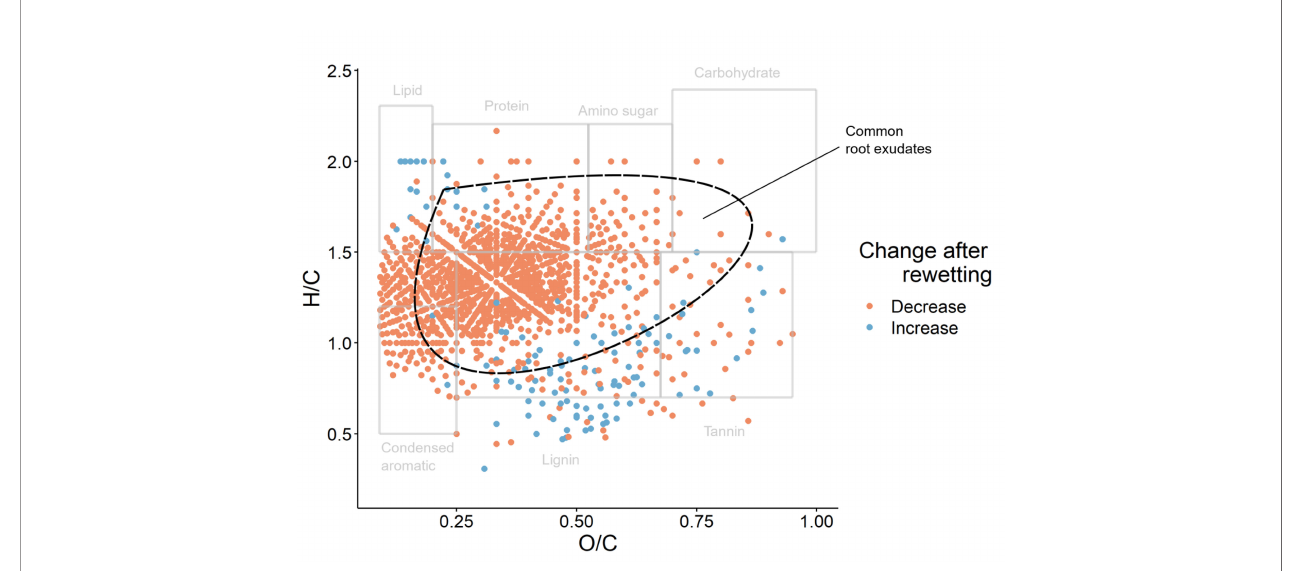
FIGURE 6 | Van Krevelen plot of sum formulae with a signi fi cant correlation with time after rewetting (p < 0.05). Grey boxes indicate areas of the van Krevelen plot that are commonly populated by certain compound classes (42). The area where common root exudates are found is marked by a dashed black line